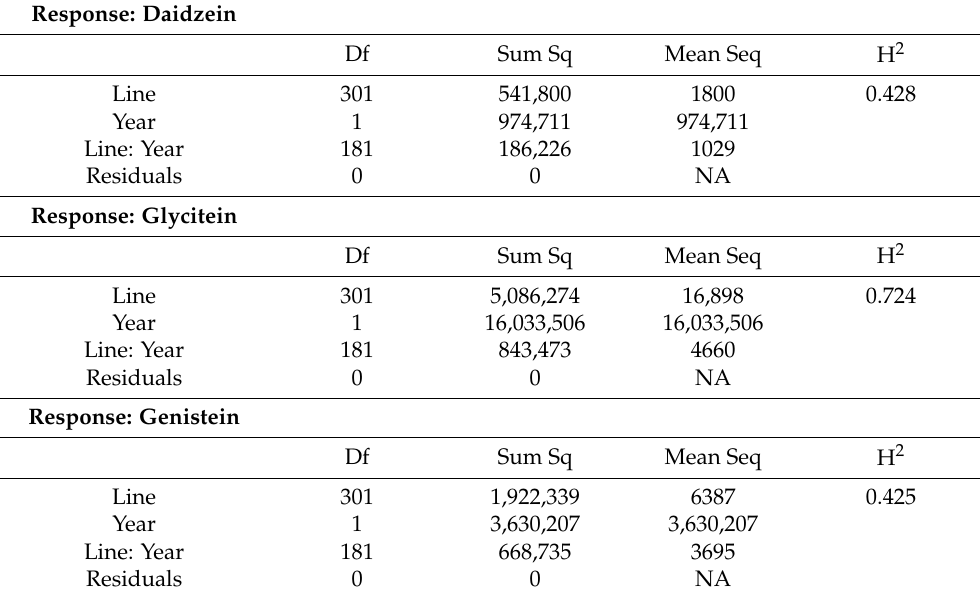
Table 3. Two-way ANOVA results for daidzein, genistein, and